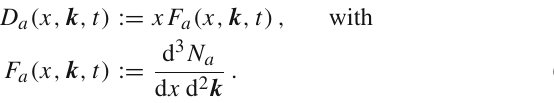
corresponding to the splitting time in the complex conjugate ampli- tude. The two upper lines live in the amplitude, and have “mass” = ( 1 − z )ω ω = z ω ω 2 0 and 1 0 , respectively from the top, while the lower line lives in the c.c. amplitude, and carries ω